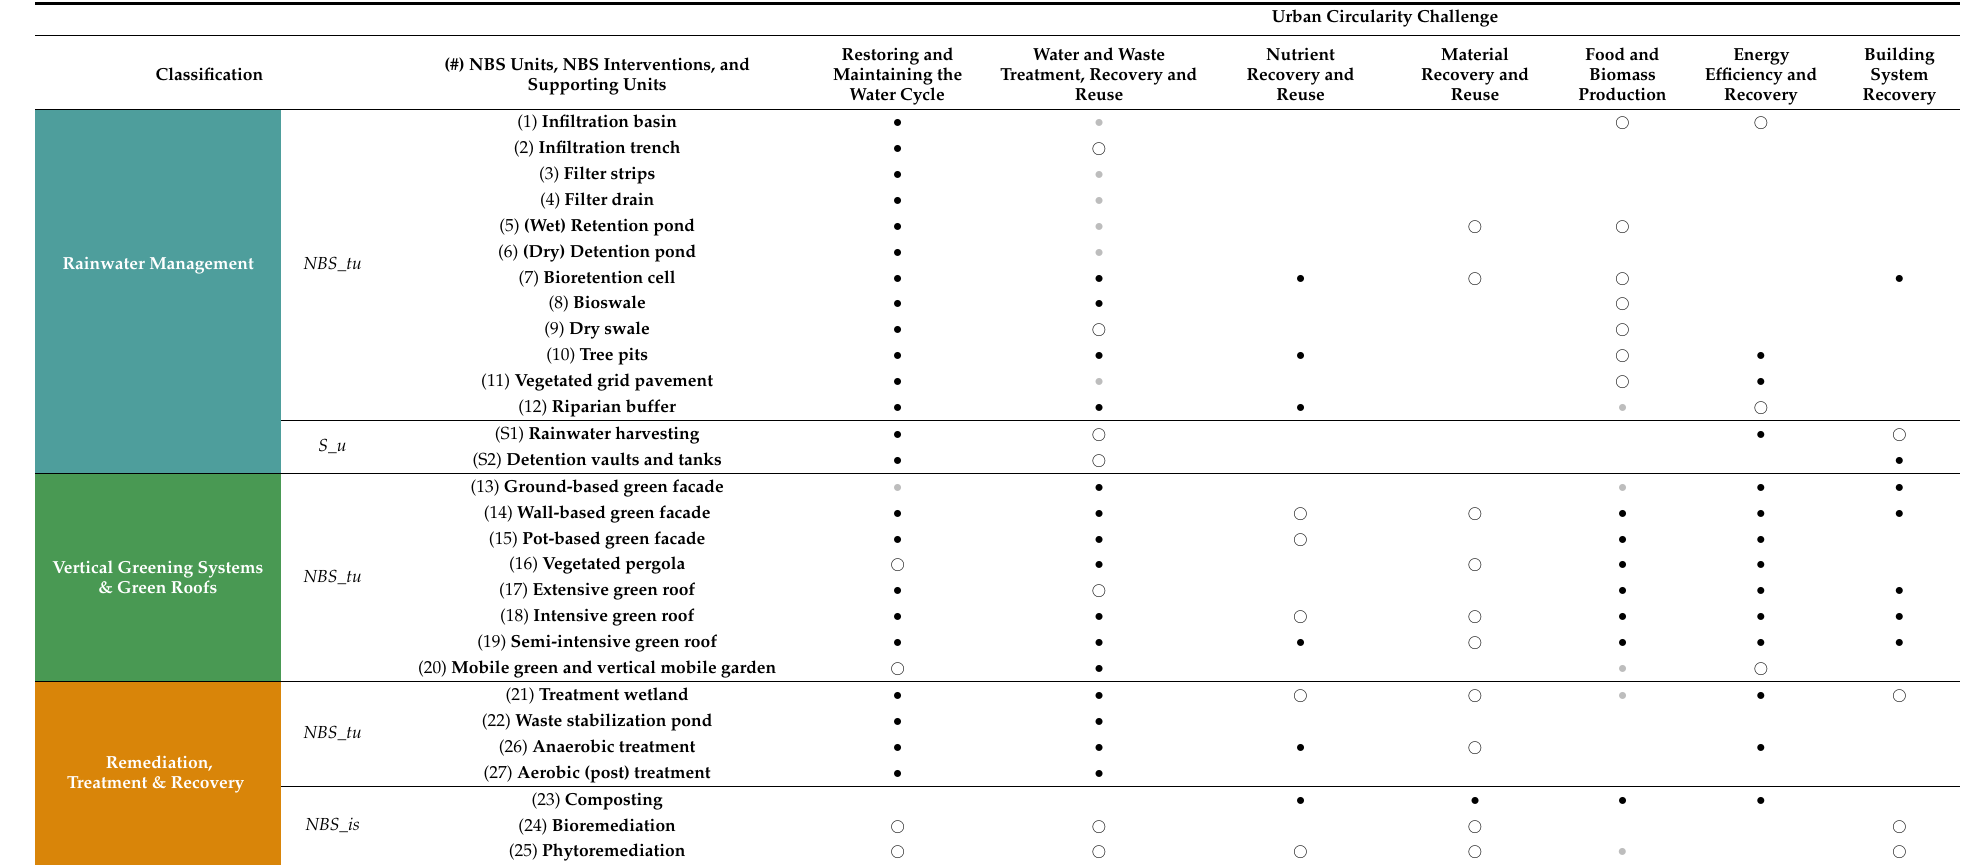
Table 1. Urban Circularity Challenges (UCCs) addressed by NBS units (NBS_u), NBS interventions (NBS_i), and Supporting units (S_u) ( • = addressing the challenge; • = contribution to challenge mitigation; = potential contribution, depending on the design; and as an “empty cell” = not addressing the challenge). NBS_tu = technological units; NBS_su = spatial units; (cid:35) NBS_is = interventions; NBS_ir = river interventions; and S_u = Supporting